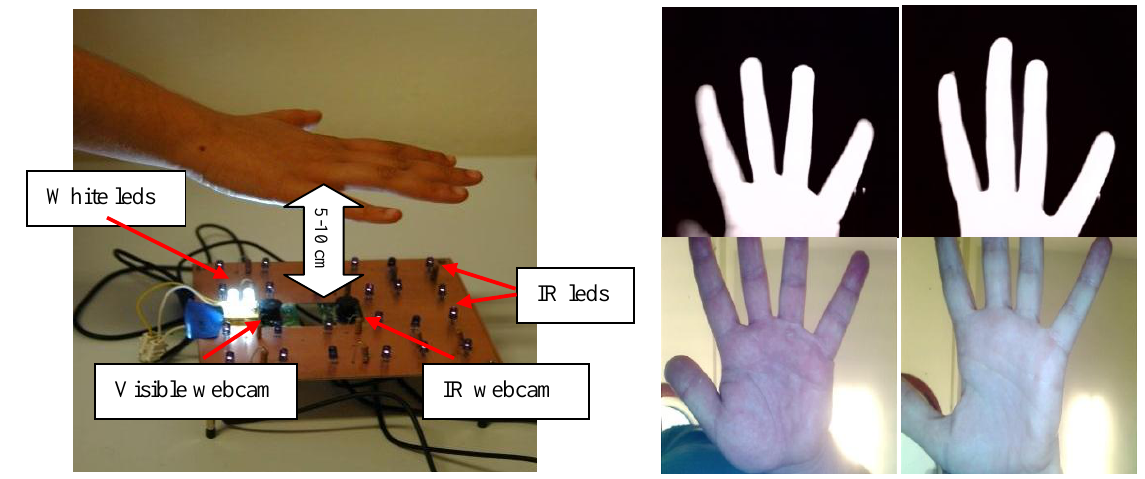
Figure 6. Contactless acquisition system at a short distance (figure on the left) and acquired IR and visible hand images from two different users (four figures on the right in upper level IR images; in down level visible images).